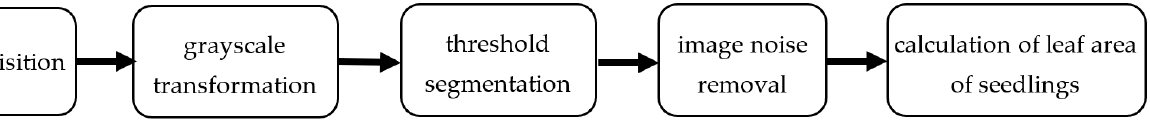
Figure 3. Flowchart for image processing.